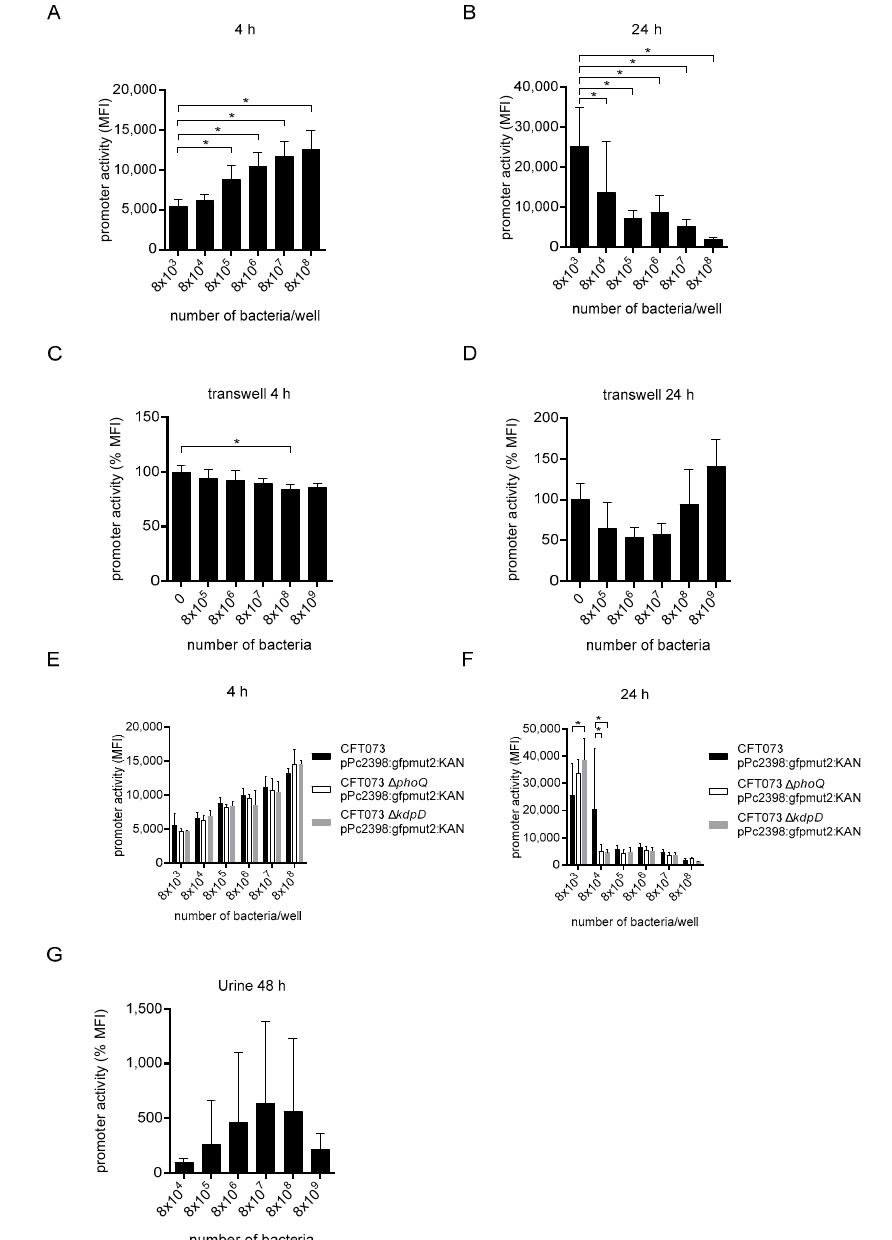
Figure 7. The bacterial density activates P2. We cultured CFT073 pPc2398:gfpmut:KAN in McCoy medium in the indicated amounts for 4 ( A ) or 24 h ( B ). We repeated the experiment using transwell cultures with CFT073 pPc2398:gfpmut:KAN (3.2 × 10 7 bacteria/well) in the absence or presence of increasing amounts of CFT073 as indicated for 4 ( C ) and 24 h ( D ). We analyzed the influence of the two-component systems KdpD/E and PhoQ/P to sense bacterial density by repeating the experiment in A and B with the strains CFT073 pPc2398:gfpmut:KAN, CFT073 Δ kdpD pPc2398:gfpmut:KAN or CFT073 Δ phoQ pPc2398:gfpmut:KAN for 4 ( E ) or 24 h ( F ). In ( G ) we cultured CFT073 pPc2398:gfpmut:KAN in the indicated amounts for 48 h in urine. In all experiments we determined the P2 promoter activity by flow cytometry. Graphs ( A , B ) depict nine independent experiments, each with one replicate, ( C ) depicts two independent experiments, each with two replicates, ( D ) depicts three independent experiments with two replicates, and ( E – G ) depict three independent experiments. Experiments in ( E , F ) were performed with one, in ( G ) with four replicates. The measured promoter activity in ( C , D ) was normalized to the “0” control. * p < 0.05, ANOVA post-hoc Tukey ( A – D , G ), two-way ANOVA and Dunnett’s multiple comparison test ( E , F